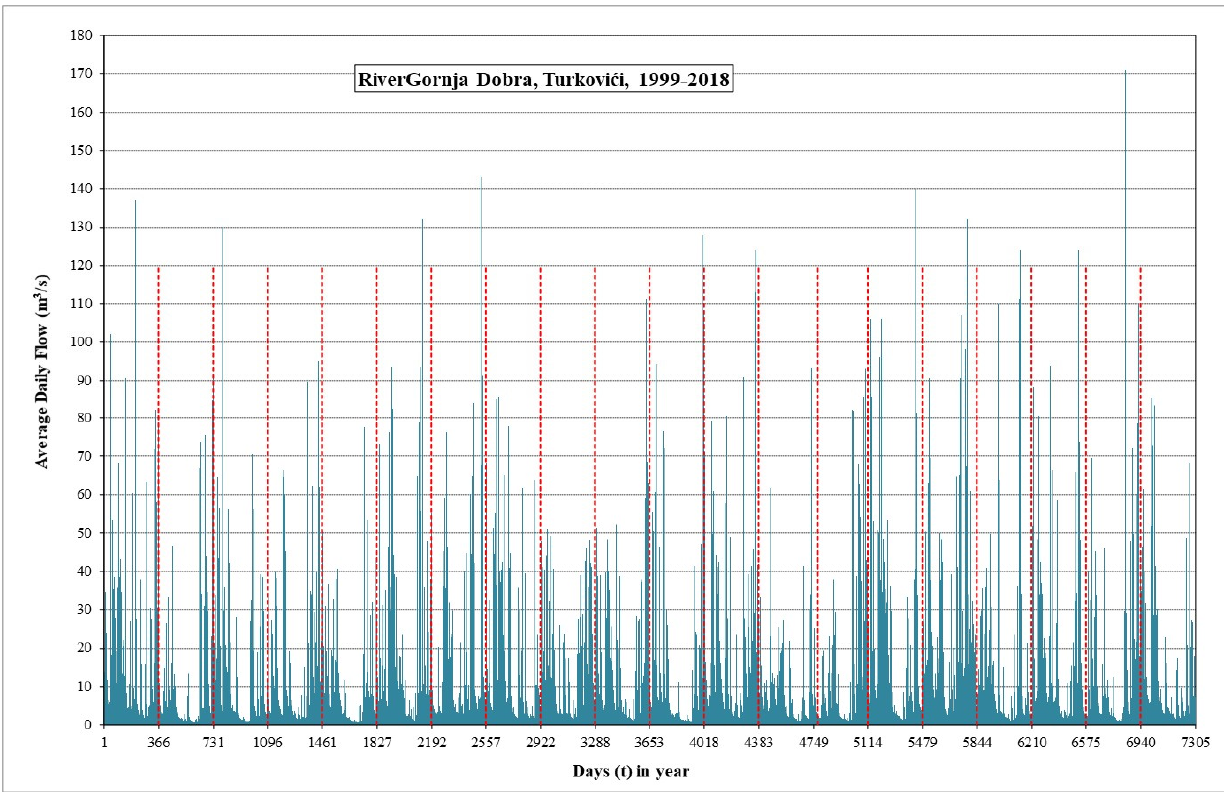
Figure 4. Average daily flow for the river Gornja Dobra, 2020.